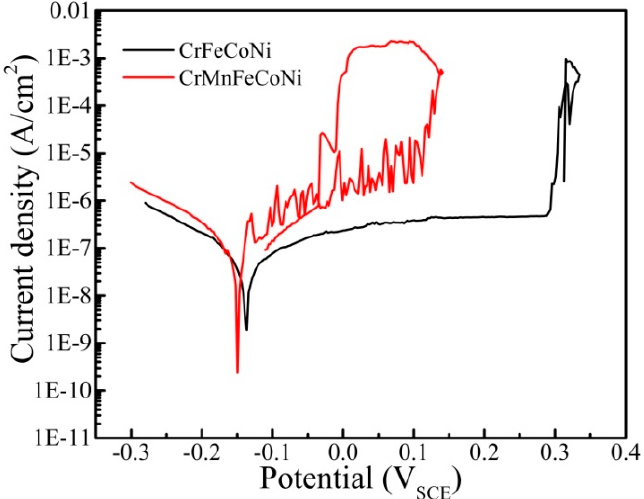
Figure 5. Cyclic potentiodynamic polarization curves of the CrFeCoNi and CrMnFeCoNi coatings in 3.5 wt% NaCl